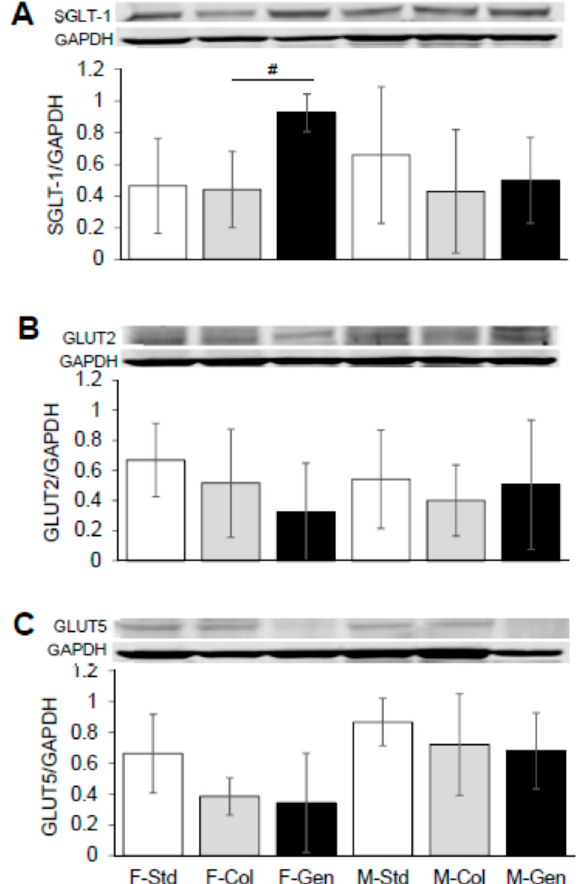
Figure 4. Effect of dietary genistein on total expression of SGLT-1, GLUT2 and GLUT5 in jejunum of ∆ F508-CF mice. ( A ) Typical western blot demonstrating SGLT-1 expression (normalized to GAPDH) in jejunum from CF mice. Average SGLT-1/GAPDH ratio is shown comparing regular standard diet, standard diet plus colyte and genistein diet. n = 4–7/group. ( B ) Typical western blot demonstrating GLUT2 expression (normalized to GAPDH) in jejunum from CF mice. Average GLUT2/GAPDH ratio is shown comparing regular standard diet, standard diet plus colyte and genistein diet. n = 4–8/group. ( C ) Typical western blot demonstrating GLUT5 expression (normalized to GAPDH) in jejunum from CF mice. Average GLUT5/GAPDH ratio is shown comparing regular standard diet, standard diet plus colyte and genistein diet. n = 4–8/group. Note: Std = standard diet, Col = colyte treated, and Gen = genistein diet. Values are means ± SD. # denotes statistical genistein-mediated effect, p < 0.05.